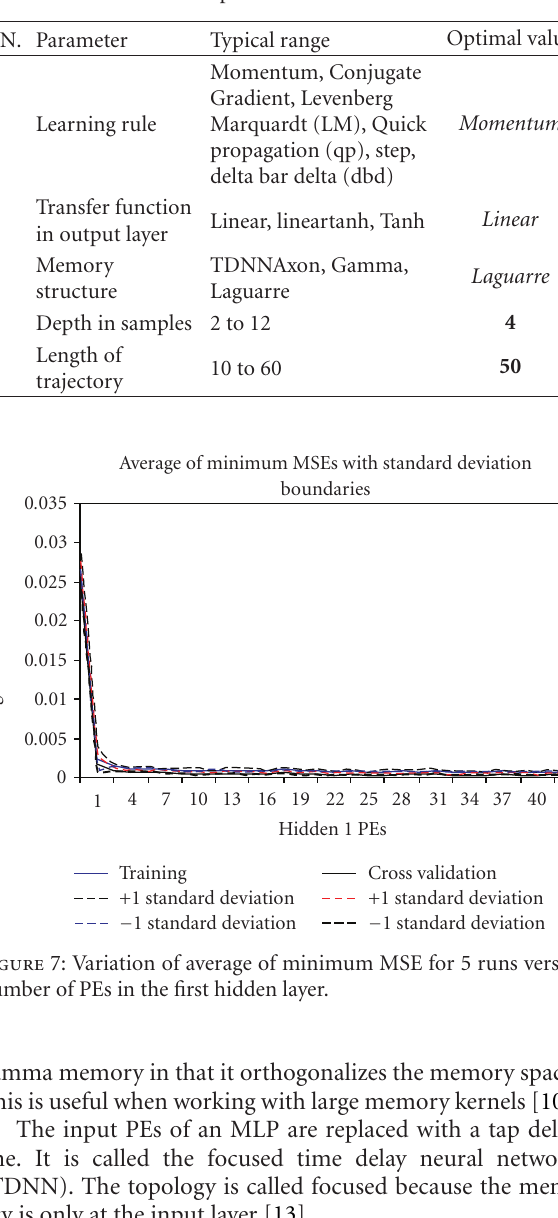
Table 5: Variable parameters of FTLRNN model.